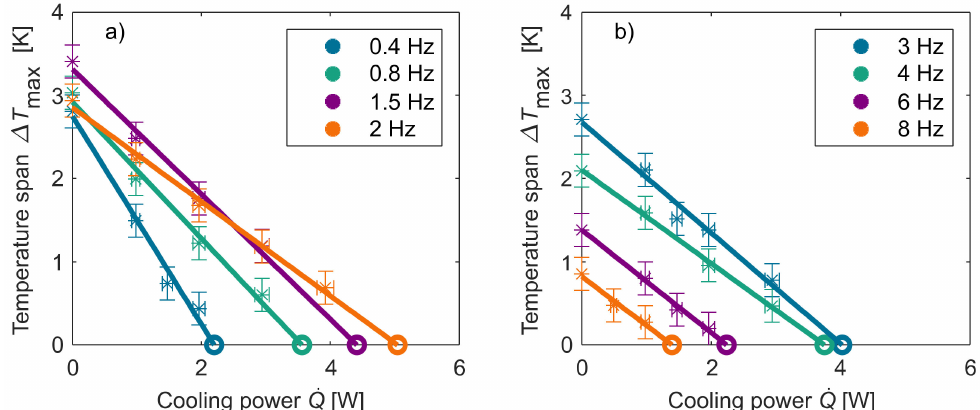
Figure 5. The temperature span between the evaporator (heat source) and the temperature-controlled condenser (heat sink) in relation to the cooling power applied for different frequencies. The maximum cooling power at a temperature span of 0 K can be deduced by means of linear extrapolation. ( a ) Frequencies from 0.4 Hz to 2 Hz. ( b ) Frequencies from 3 Hz to 8 Hz.